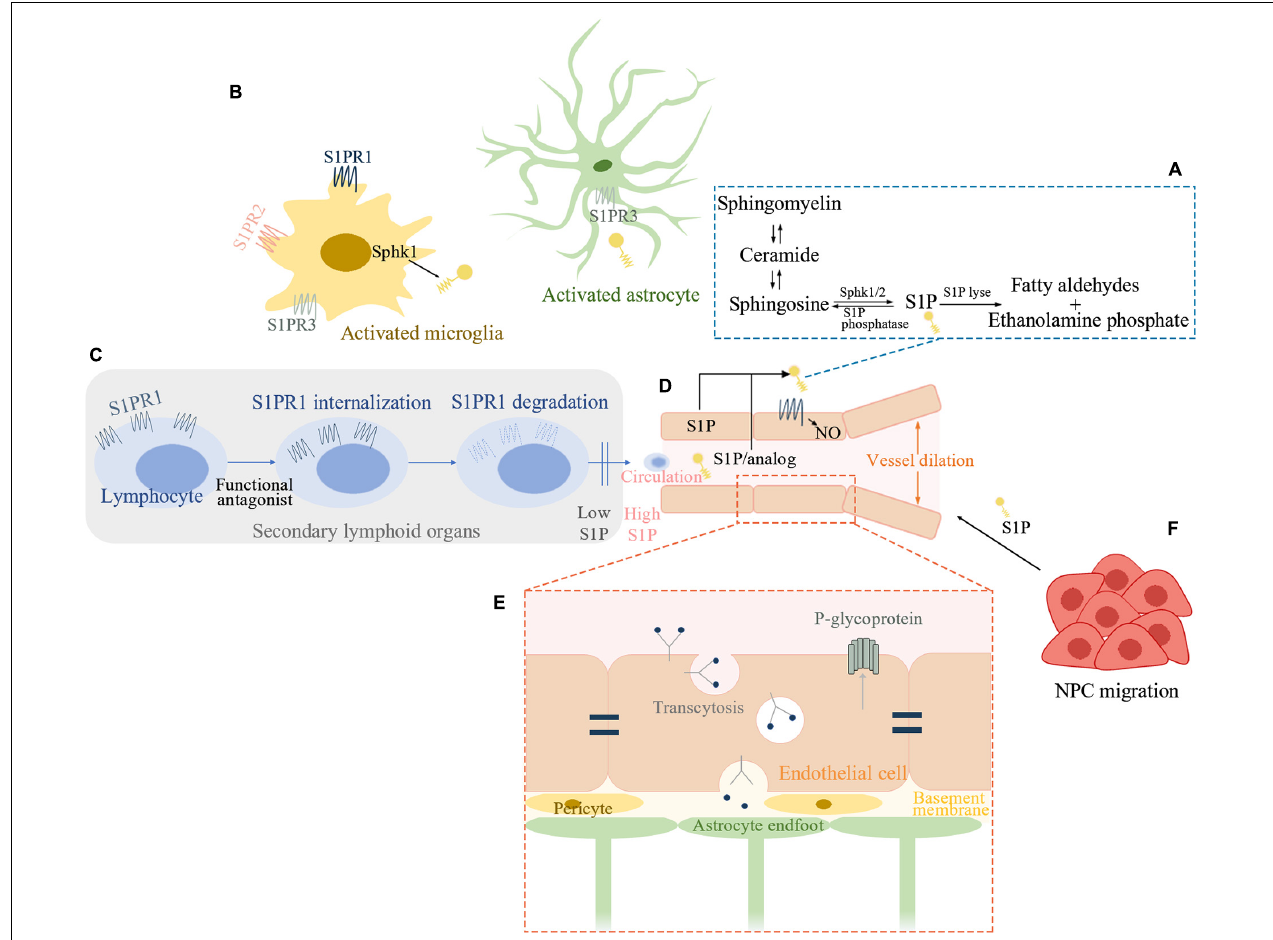
FIGURE 1 | Sphingosine1-phosphate (S1P) signaling pathway involved in ischemic stroke. (A) Schematic outline of S1P metabolism. (B) S1P signaling in post-ischemic brain inflammation. Sphk1 level is elevated in microglia and S1P production is enhanced in activated microglia. S1PR1, S1PR2, and S1PR3 influence microglial activation. Astrocytes interact extensively with microglia. S1P can activate astrocytes while S1PR3 is known to promote astrogliosis in ischemic brain. (C) S1P and recruitment of peripheral lymphocytes. Functional antagonist of S1PR1 can induce receptor internalization and degradation and thereby inhibits peripheral lymphocytes’ recruitment. (D) S1P signaling in sustaining endothelial functions. S1P-S1PR1-nitric oxide regulates vessel dilation to flow. S1PR1 distributes to the abluminal surface of the endothelial cells. Either cell-autonomous S1P or system S1P/analog which penetrates the blood-brain barrier (BBB) can activate endothelial S1PR1 and sustains endothelial function. (E) S1P inhibits the function of P-glycoprotein at the BBB. Brain endothelial S1PR1 may help maintain BBB function by sustaining a proper distribution of tight junction proteins. Endothelial S1PR1 may participate in regulating vesicular transport in the early phase of BBB opening after ischemic stroke. (F) S1P is a chemoattractant for neural progenitor cells (NPC) toward the infarcted area thus facilitating neurogenesis. Sphk, sphingosine kinase; S1P, sphingosine-1-phosphate; S1PR, S1P receptor; NO, nitric oxide; NPC, neural progenitor